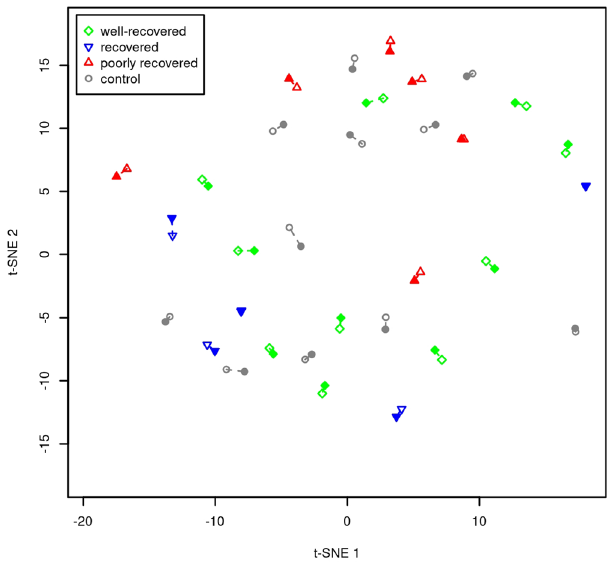
Figure 4. T-SNE mapping of the global DNA methylome profiles across the recovery groups of SWD group. Colors of the dots correspond to the different groups: red, poorly recovered; blue, recovered; green, well- recovered; grey, controls. Hollow markers represent samples collected during work and filled ones during vacation, dashed lines connecting the samples of each